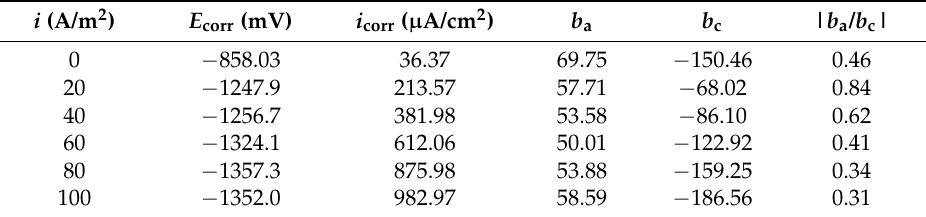
Table 2. The electrochemical parameters of 3PE-coated X80 steel samples under DC cathode polarization at different DC current